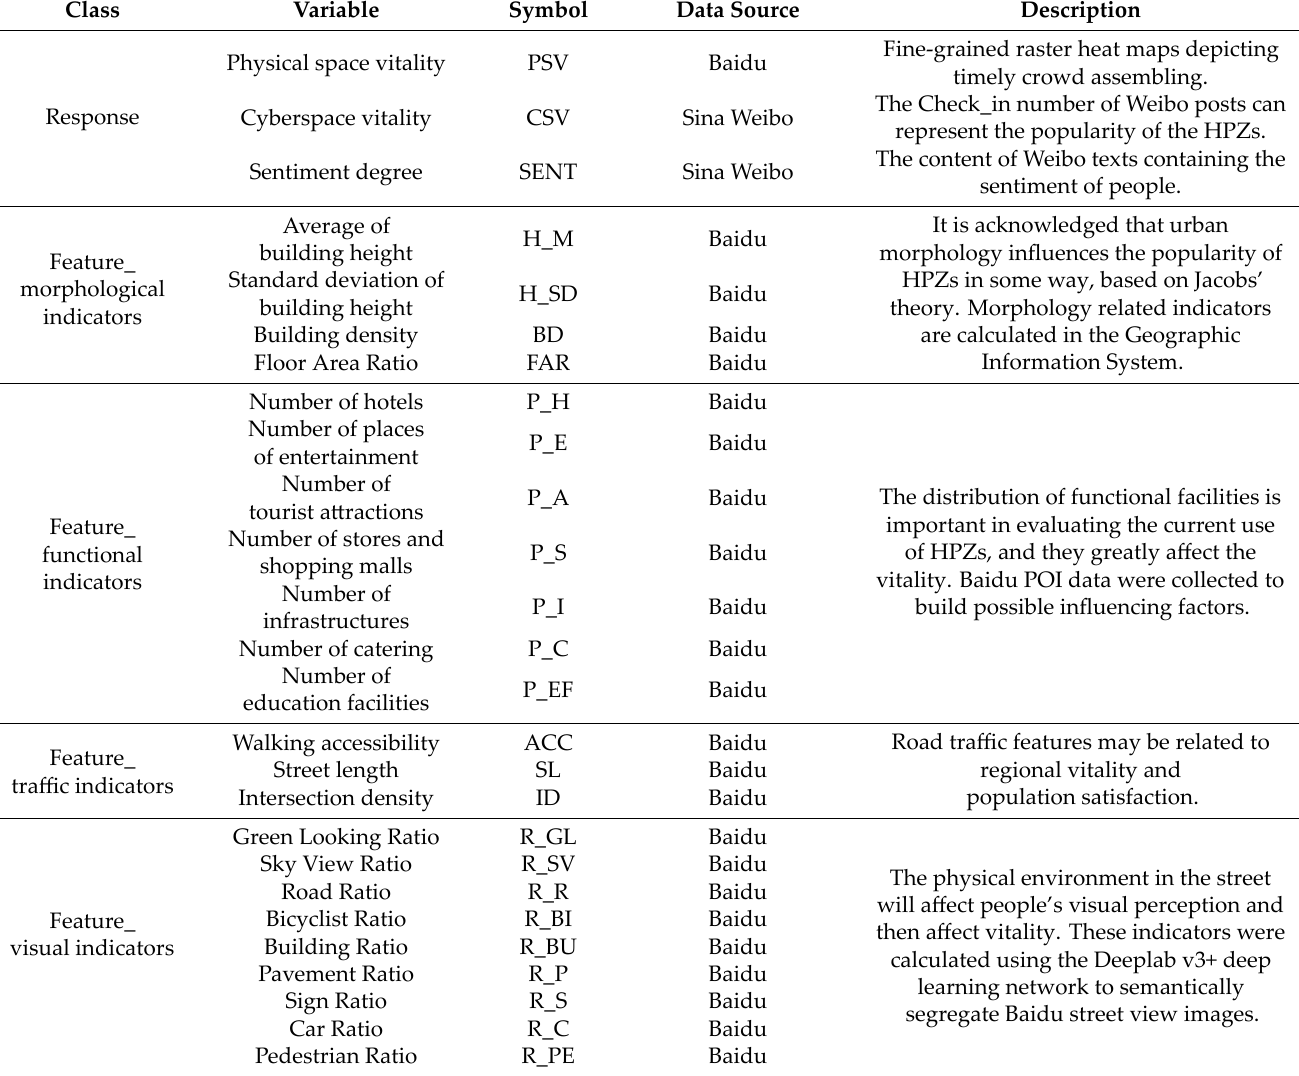
Table 1. Multi‑source data acquisition and indicator calculation